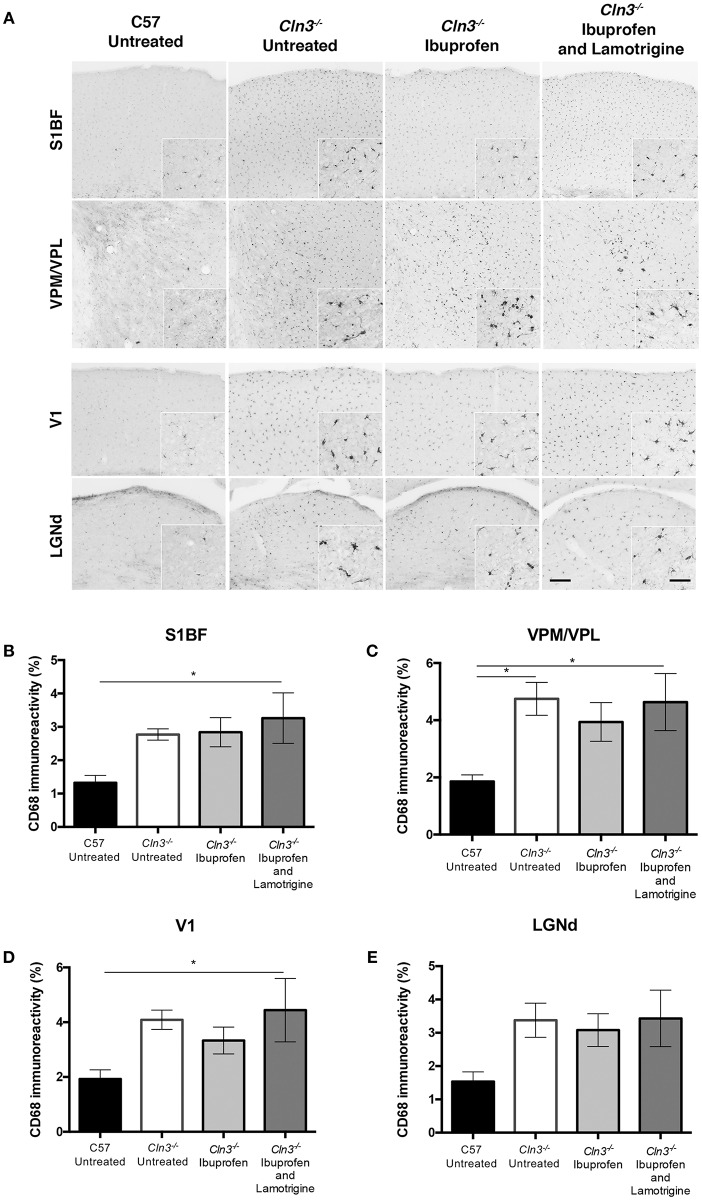
Effect of Ibuprofen and Lamotrigine treatment on microglial reactivity in 9-month old Cln3−/− mice. (A) Representative images of CD68 immunostaining in S1BF, VPM/VPL, V1, and LGNd. Scale bars, 200 and 25μm (inserts). (B–E) Quantification of % CD68 immunoreactivity in S1BF, VPM/VPL, V1, and LGNd, respectively. Data points represent mean ± S.E.M. of the % CD68 immunoreactivity. Ordinary one-way ANOVA was applied with Bonferroni's post-test (*p < 0.05).